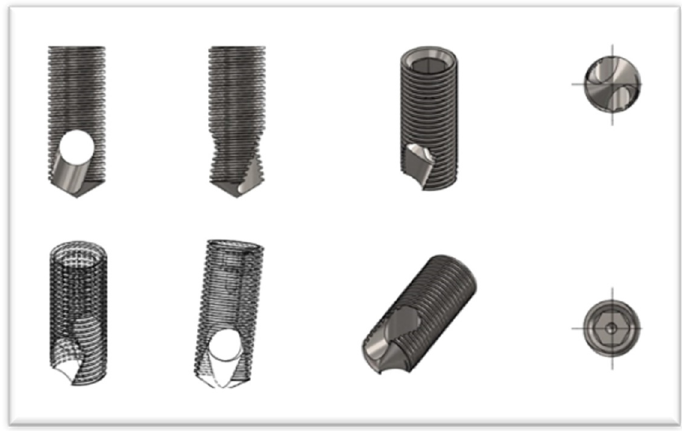
Figure 1. New biomechanical screw (BKS) of 4 mm width and 10 mm length. Table 1. Mechanical Properties [23].